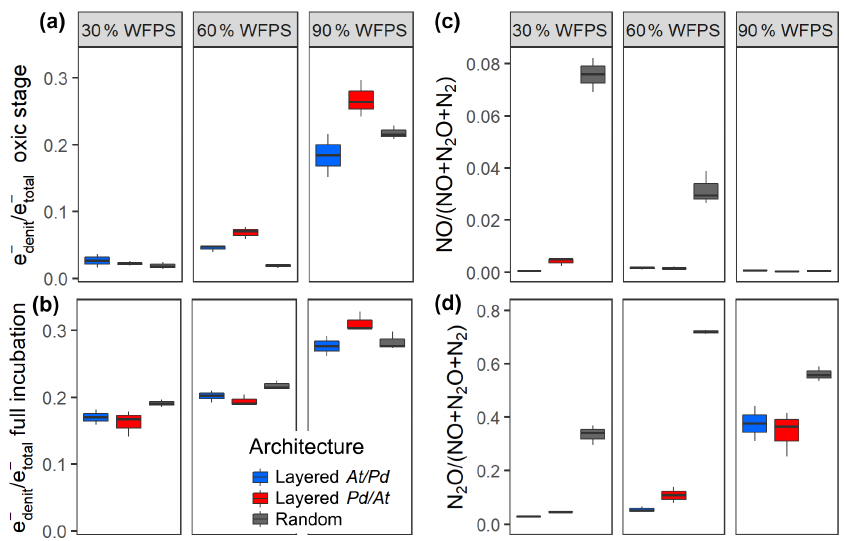
Figure 5. The proportion of denitrification in total respiration expressed as relative electron flow for all architectures and saturations. Values are reported for (a) the initial, oxic to hypoxic stage (O 2 present in headspace) and (b) for the full incubation period of 300h. The product ratios for NO (c) and N 2 O (d) consider the full incubation period and are corrected for the release of precursor gases. Data shown as box–whisker plots: whiskers – min and max; middle lines –